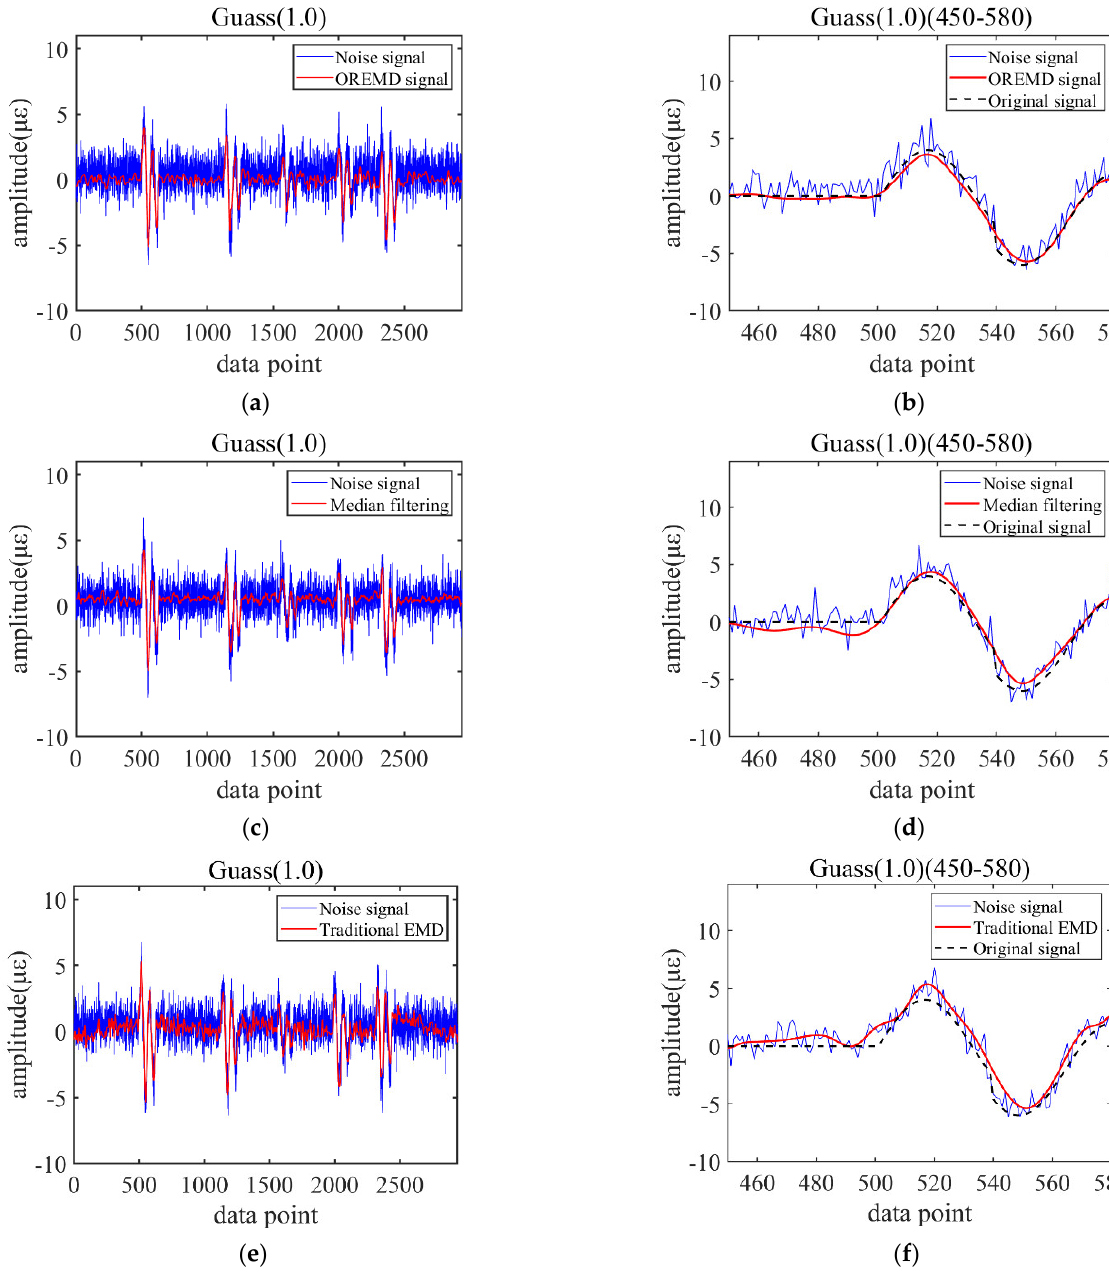
Figure 8. Signal sifting results: ( a , b ) OREMD. ( c , d ) Median filtering. ( e , f ) Traditional EMD. The MSE of OREMD is 0.2015. The median filter width is taken as M = 18, and the optimal MSE is 0.3183. The MES of traditional EMD is 0.6599. The sieving error using the conventional EMD method is relatively large, so median filtering is used as a comparison in the subsequent content. Intercepting the original effective signal x ( t )[ 450 − 580 ] segment (Figure 8b,d,f), OREMD sifting is smoother and has higher similarity. To further verify the sifting effect of different noise levels, Gaussian noise with mean 0.5 and variance 0.5, 1.5, and 2 were added to the original signal to form a new test signal (), (), () . The results are shown in Figure 9. . .